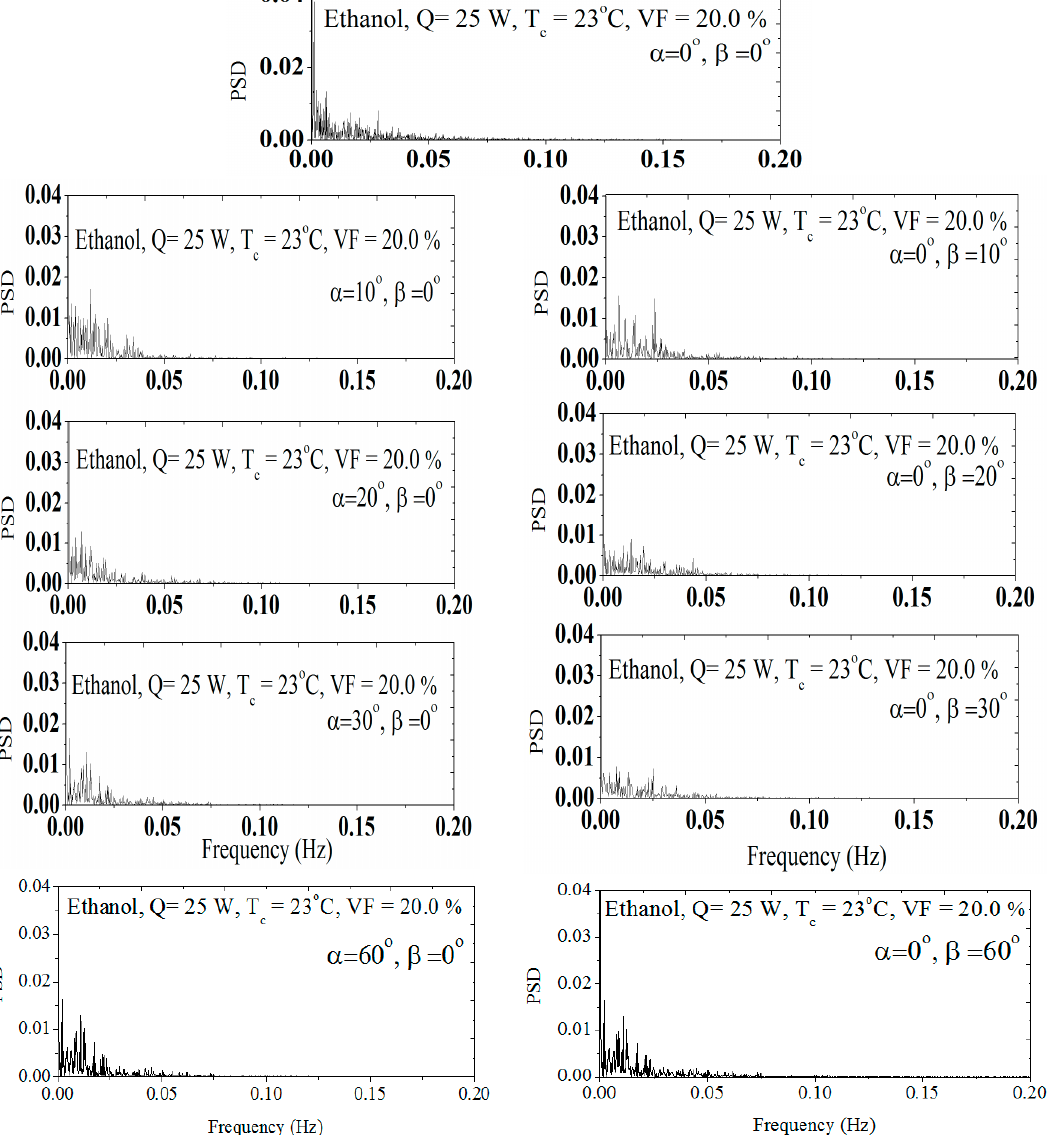
Figure 9. FFT PSD Distribution with Different Orientation (#No. 13), Q = 25 W.